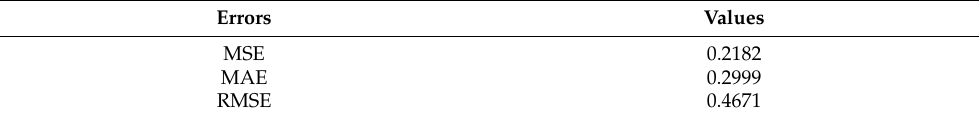
Table 11. Errors of solar radiation prediction using ARMA (2,1).